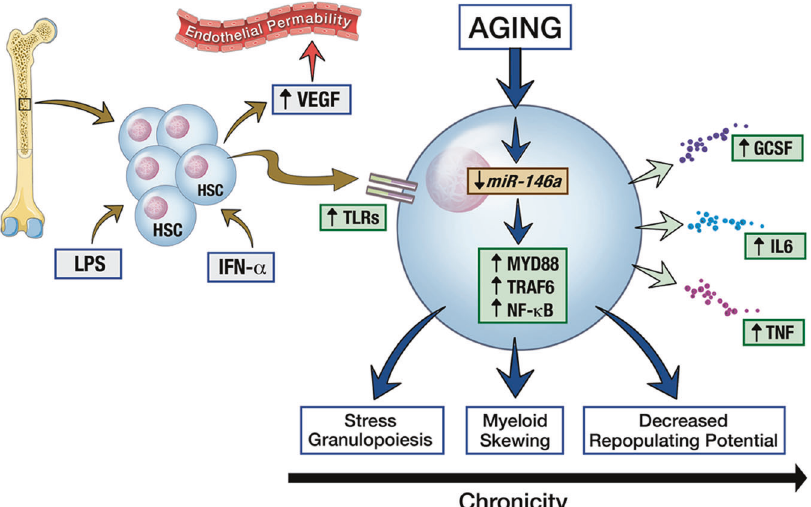
Fig. 1 The role of in fl ammation in hematopoietic stem cell (HSC) differentiation — In fl ammation and antigen stimulation have a number of downstream effects on HSC differentiation. Extrinsic stimuli, such as interferon alpha (IFN- α ) or lipopolysaccharide (LPS) have been shown to activate toll-like receptors (TLRs) 2, 4, and 9 on HSCs. This can result in secretion of vascular endothelial growth factor (VEGF), which increases endothelial permeability. It also results in intracellular activation of MYD88, leading to downstream activation of TRAF6 and NF-kB. Similarly, aging results in a decrease in miR-146a expression, which can also activate MYD88, TRAF6, and NF-kB. This activation results in autocrine and paracrine signaling through cytokines and chemokines, such as granulocyte colony stimulating factor (G-CSF), interleukin 6 (IL6), and tumor necrosis factor (TNF). In the acute state this results in stress granulopoiesis and terminal myeloid differentiation. Over time, prolonged signaling can result in myeloid skewing and a loss of HSC repopulation